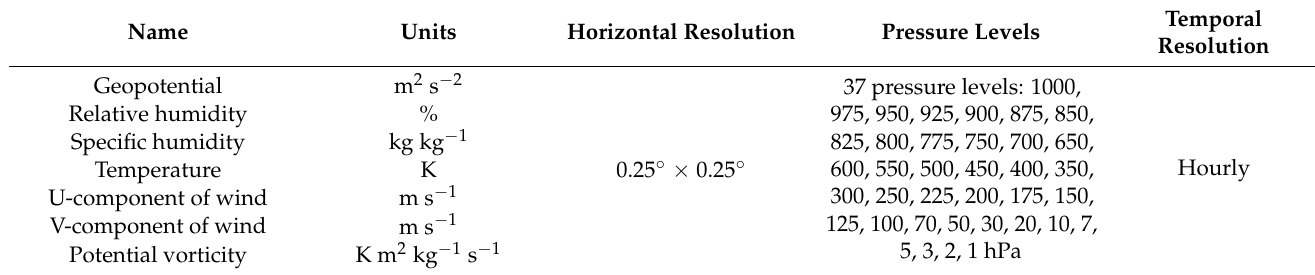
Table 2. ERA5 physical variables that are used to calculate environmental